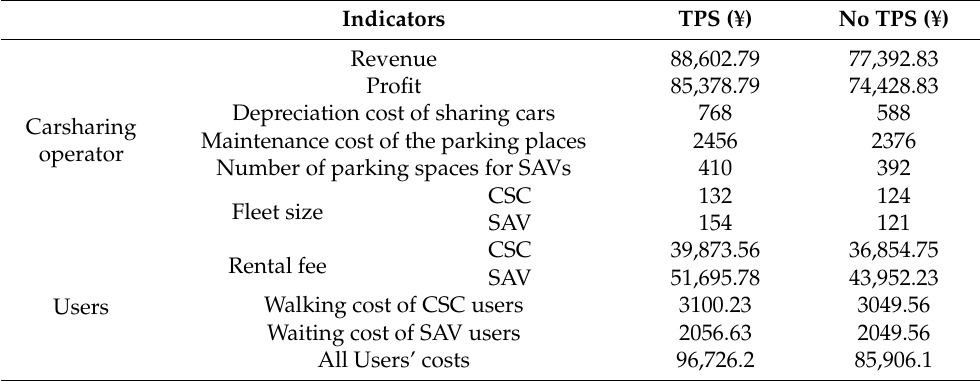
Table 6. Performance of the hybrid carsharing system with or without the